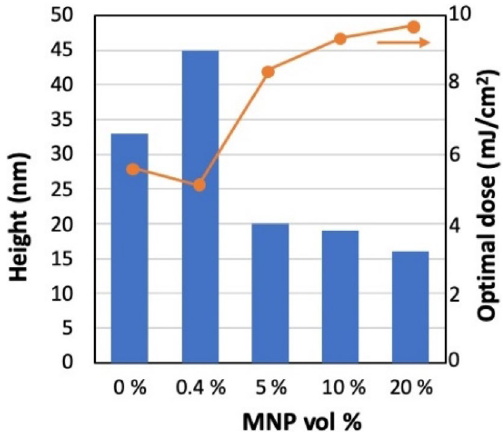
Figure 8. Structure height and optimal dose to obtain this height as a function of the MNP concentration. Interference lithography, Period: 600 nm.